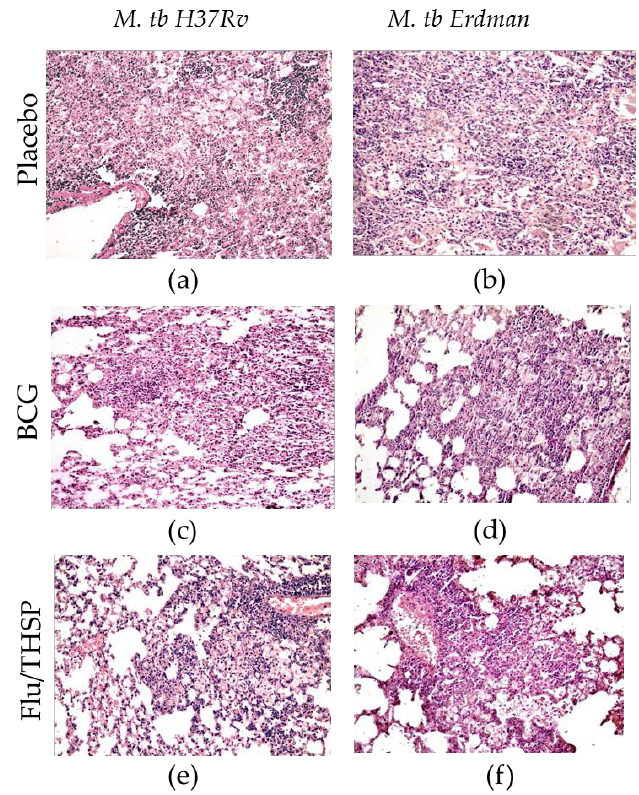
Figure 5. Protective efficacy of Flu/THSP against lung pathology in a mouse model of TB infection. Representative hematoxylin and eosin (H&E) stained lung histological sections of vaccinated and control mice (indicated on the left) after infection with highly virulent M. tb H37Rv or M. tb Erdman strains (indicated above), magnification is 300X. ( a , b )—merged foci of specific infiltration without a clear spatial orientation of the cells; ( c , d )—small foci of specific infiltration, lymphocytes, foamy macrophages, epithelioid cells, and single neutrophilic leukocytes; ( e , f )—small alveolar-macrophage infiltrates, perivascular lymphohistiocytic infiltration. Protective efficacy of prime-boost vaccination protocol with first BCG immunization and second Flu/THSP immunization was accessed in comparison to single BCG vaccina- tion or placebo in the guinea pig model. Animals were vaccinated and then challenged with the virulent M. tuberculosis strain H37Rv. After 8.5 weeks of the infection process, guinea pigs were sacrificed, and their organs were analyzed for tuberculosis damage and bacterial load. The robust protective effect was demonstrated accessing the level of bacterial load in lung and spleen, which was significantly lower in prime-boost vaccinated animals than in BCG group (mean decrease by 0.77 lg CFU and 0.72 lg CFU in the lungs and spleen, re- spectively) (Figure 6a,b). Furthermore, the relative mass coefficient of the spleen was sig- nificantly lower for prime-boost vaccinated guinea pigs than for BCG or placebo vac- cinated animals (Figure 6c).